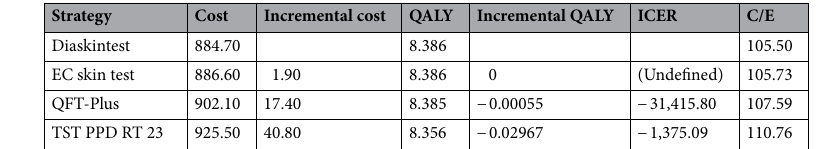
Table 2. Strategy rankings—all referencing common baseline (in US$ 2020). QALY quality-adjusted life year, ICER incremental cost-effectiveness ratio, QFT-Plus QuantiFERON TB Gold Plus, TST tuberculin skin test, PPD RT 23 purified protein derivative, C/E cost effectiveness, US$ US